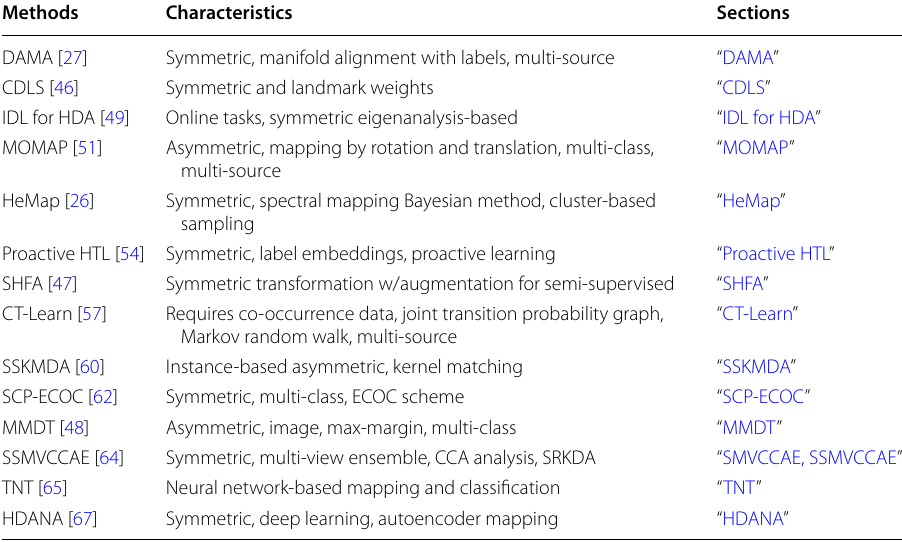
Table 2 Surveyed HTL methods which require limited target labels and accept unlabeled target data